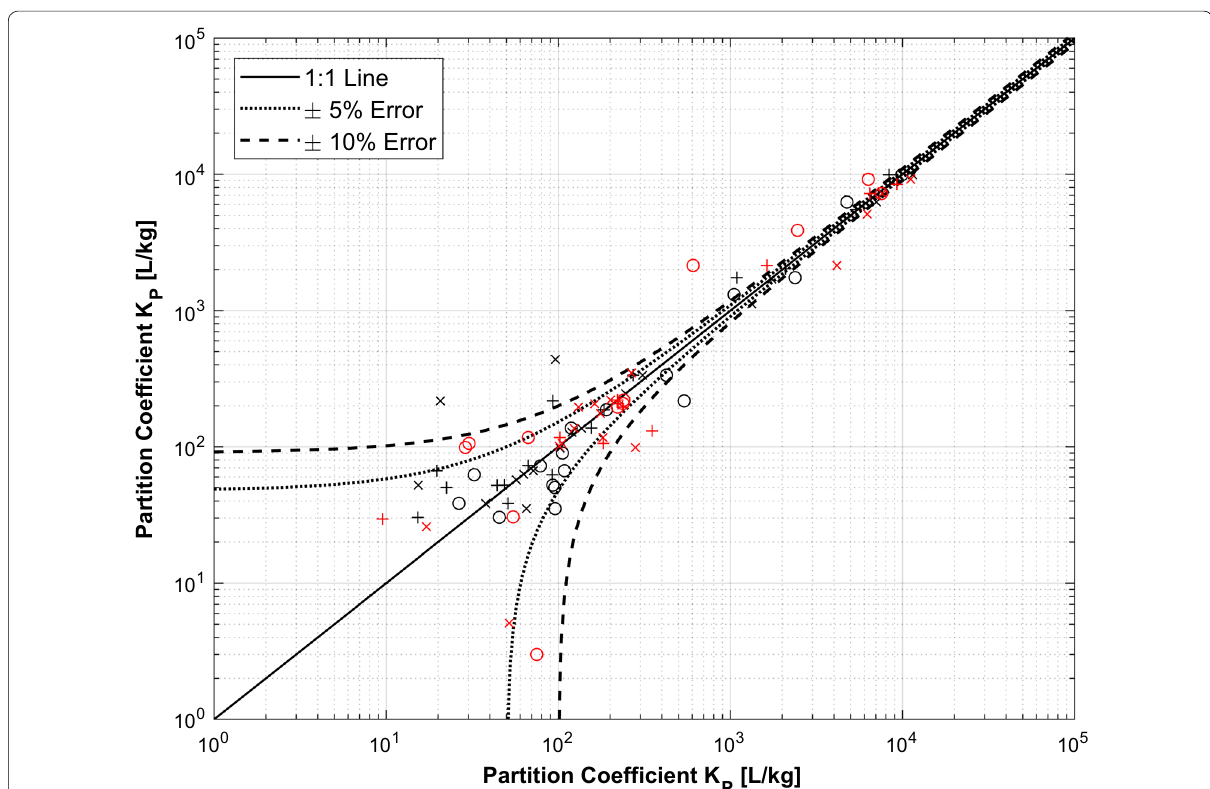
Fig. 3 Uncertainty of partition coefficients calculated according to Eq. 3. Uncertainties were determined with standard analytical errors of ε (dotted lines) and of ε 10% (dashed lines). The differences between the measured D P ( x -axis) and the calculated D P ( y -axis) are displayed by the = ± black and red symbols for PE and PS, respectively. Crosses, circles, and pluses indicate D P values determined at pH 4, pH 7, and pH 10,